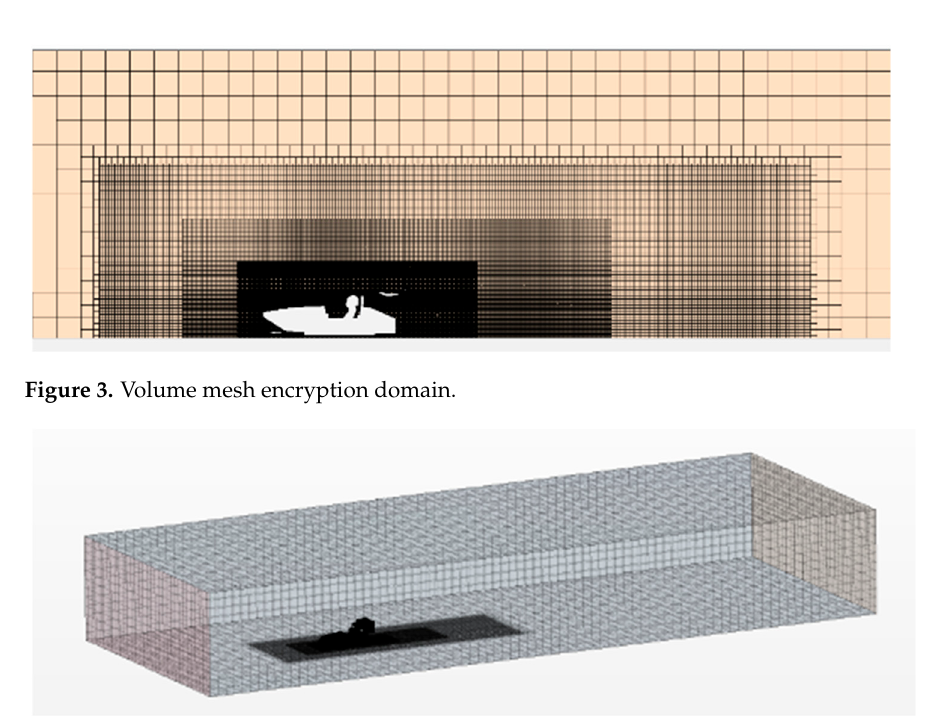
Figure 4. Encrypted computing domain.